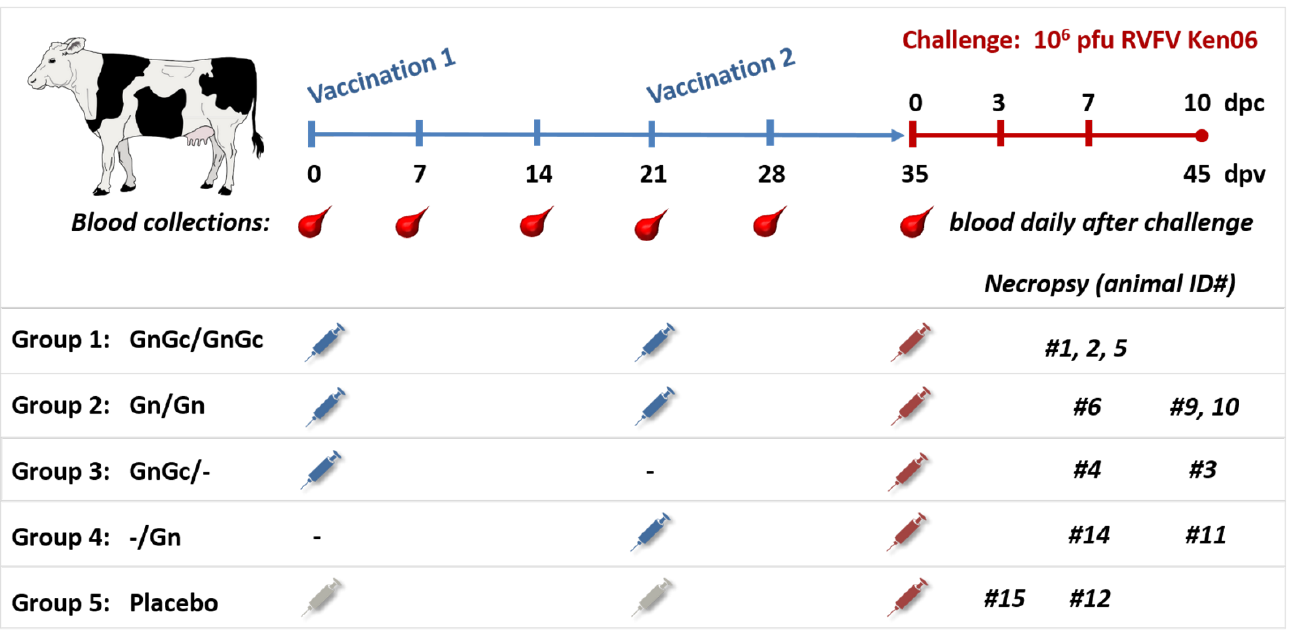
Figure 1. Study design. Twelve 4–5-month-old Holstein calves were divided into five groups for vaccination with GnGc, Gn only, or adjuvant only (placebo group). Calves were vaccinated subcutaneously at 0 and/or 21 days as indicated. At 35 days post first vaccination (dpv), calves were challenged with RVFV subcutaneously. Calf #15 died with acute RFV, and was necropsied at 3 days post challenge (dpc); the remaining calves were necropsied at 7 dpc and 10 dpc as indicated.